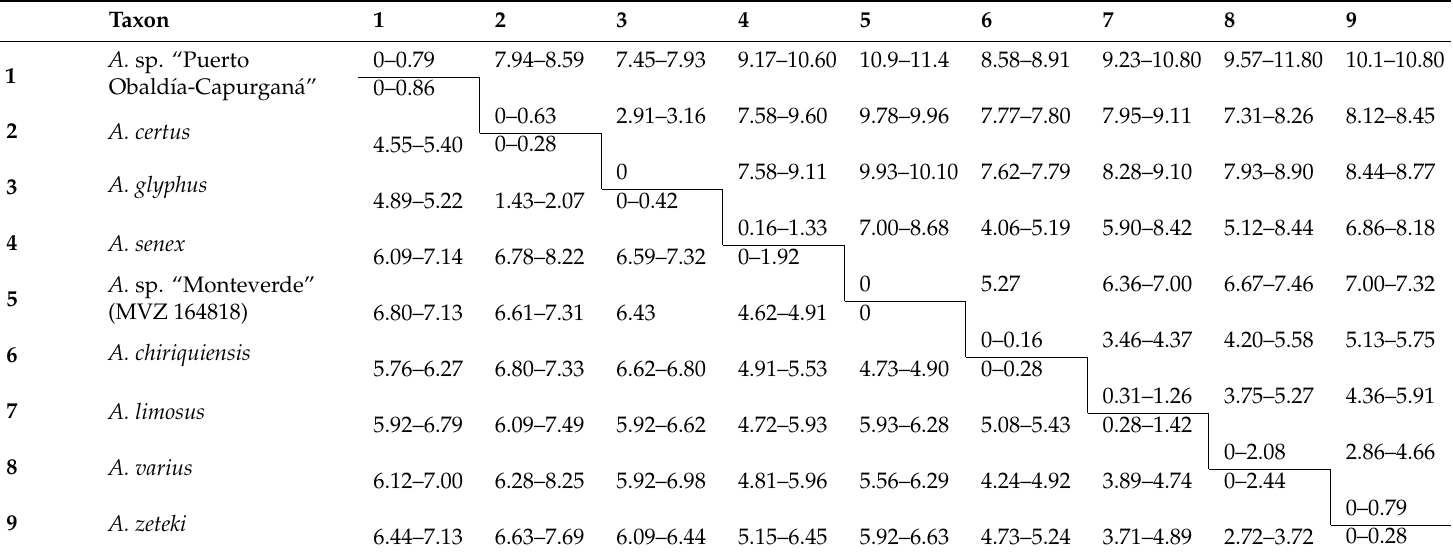
Table 2. Pairwise genetic distances obtained using a Kimura 2-parameter model of sequence evolution (i.e., K2P distance × 100) for the mitochondrial fragments of the COI and cyt b genes of the species of Atelopus from Central America. Ranges represent minimum and maximum observed distances. Intraspecific genetic distances are shown along the diagonal of the matrix. Values above and below the diagonal correspond to the interspecific genetic distances of the cyt b and COI genes,